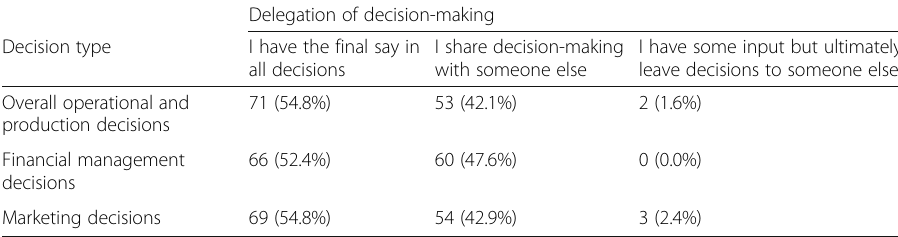
Table 2 Frequency of decision-making authority among respondents ( N = 126) Delegation of decision-making Decision type